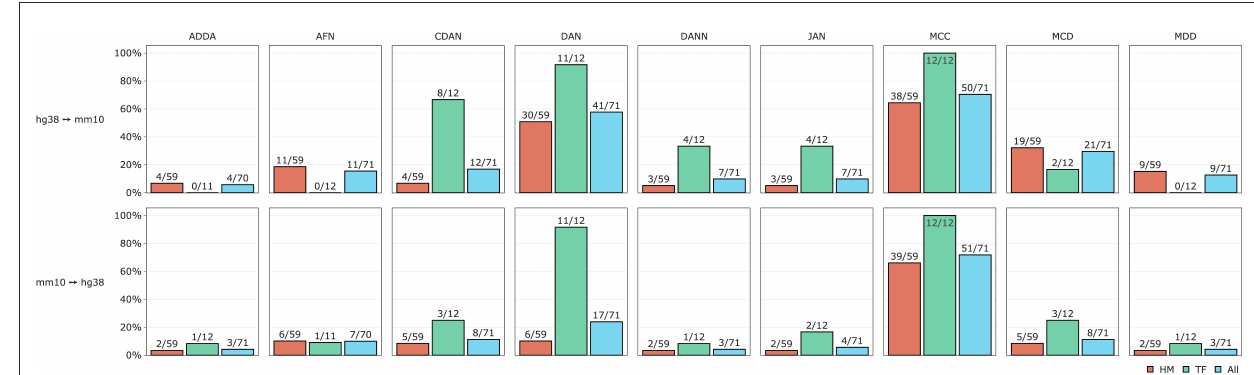
FIGURE5 Comparative performance of 9 DA models tested on TFs and HMs human-mouse and mouse-human cross-species predictions. Y axis depicts percentage of DA experiments when at least 1 out of 9 DA models worked better than the baseline model. Absolute numbers are given next to the corresponding bars.